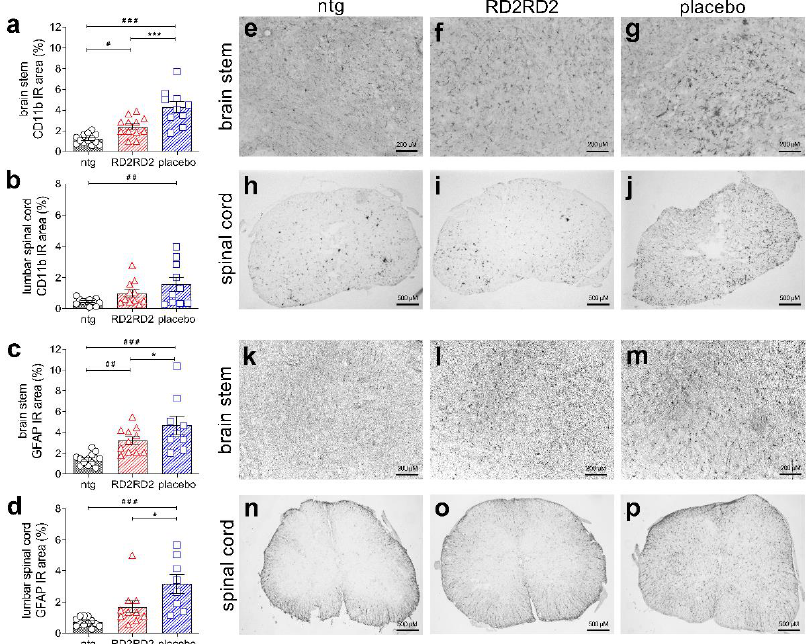
Figure 3. Immunohistochemical investigations revealed a reduction of neuroinflammation in RD2RD2-treated SOD1*G93A mice. Analysis of activated microglia and astrocytes in brain stem and lumbar spinal cord showed significant reduction of neuroinflammation (staining with CD11b and GFAP antibodies with subsequent quantification of glia cells). Presentation of the analysed cells, brain and lumbar spinal cord are given on the right (microglia: a , e – g = brain stem and b , h – j = lumbar spinal cord; astrocytes: c , k – m = brain stem and d , n – p = lumbar spinal cord). Data is presented as mean ± SEM. Statistical calculations were conducted by one-way ANOVA with Fisher’s LSD post hoc analysis, CD11b: ntg n = 13, RD2RD2 n = 12, placebo n = 10 (brain stem) and ntg n = 11, RD2RD2 n = 11, placebo n = 10 (lumbar spinal cord) and GFAP: ntg n = 13, RD2RD2 n = 11, placebo n = 9 (brain stem) and ntg n = 12, RD2RD2 n = 10, placebo n = 8 (lumbar spinal cord). Lozenges ( # ) and asterisks (*) indicate a significance between treatment groups (ntg vs. RD2RD2 or ntg vs. placebo: # p = 0.05, ## p = 0.01, ### p < 0.001 and RD2RD2 vs. placebo: * p = 0.05, *** p < 0.001). IR: immunoreactivity. Circles: placebo-treated ntg; triangles: RD2RD2-treated SOD1*G93A mice and squares: placebo-treated SOD1*G93A mice. Moreover, we analysed the number of neurons in SOD1*G93A mice in the brain stem and motor cortex (Figure 4 (a, b), and Table 1). Quantification of NeuN-positive cells re- vealed a loss of neurons in transgenic SOD1*G93A mice vs. non-transgenic littermates in both regions. Treatment with RD2RD2 significantly rescued neurons in the motor cortex to levels of non-transgenic littermates. The number of neurons in the brain stem showed the same, but non-significant, tendency (Table 1).